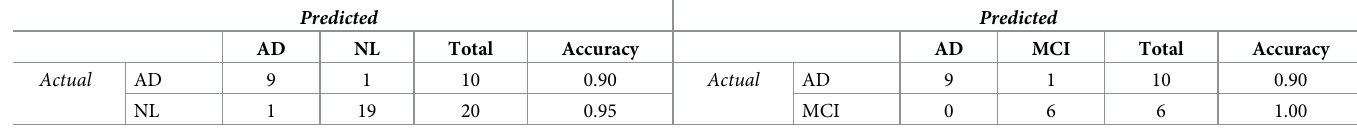
Table 3. Confusion matrices for classifying diagnoses in the test data. Left: Alzheimer’s disease vs . a healthy diagnosis. Right: Alzheimer’s disease vs . MCI. The labels are as follows, NL: healthy, MCI: mild cognitive impairment, AD: Alzheimer’s